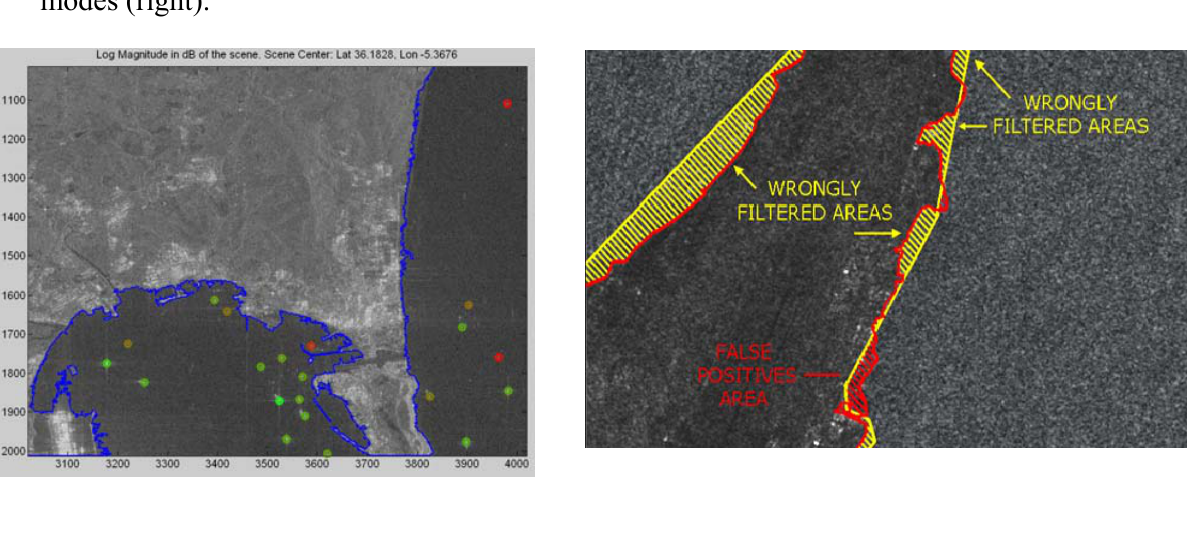
Figure 3. Snapshot of coastline isolation (blue line) for an ENVISAT image of the bay of Gibraltar (left). Differences between image (red line) and shape (yellow line) processing modes